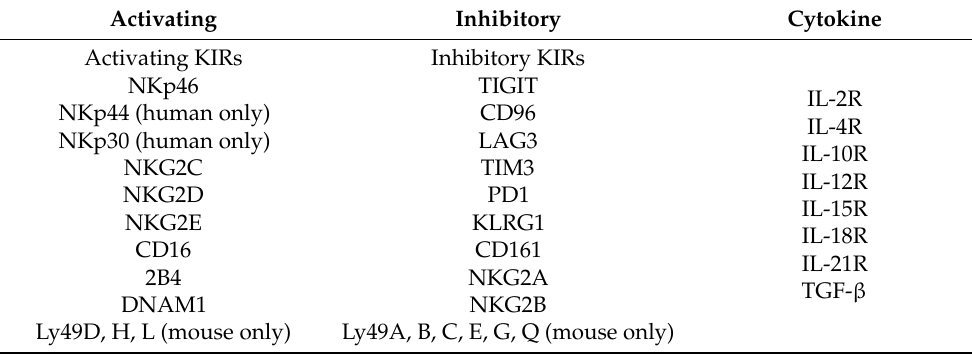
Table 1. NK activating, inhibitory and cytokine receptors in mice and humans